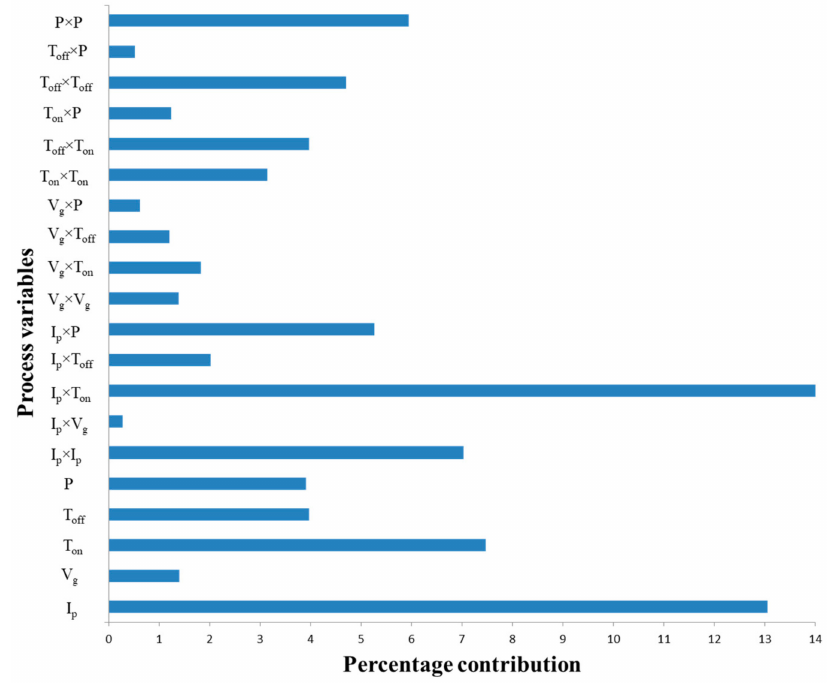
Figure 6. Percentage influence of process variables and interactions on